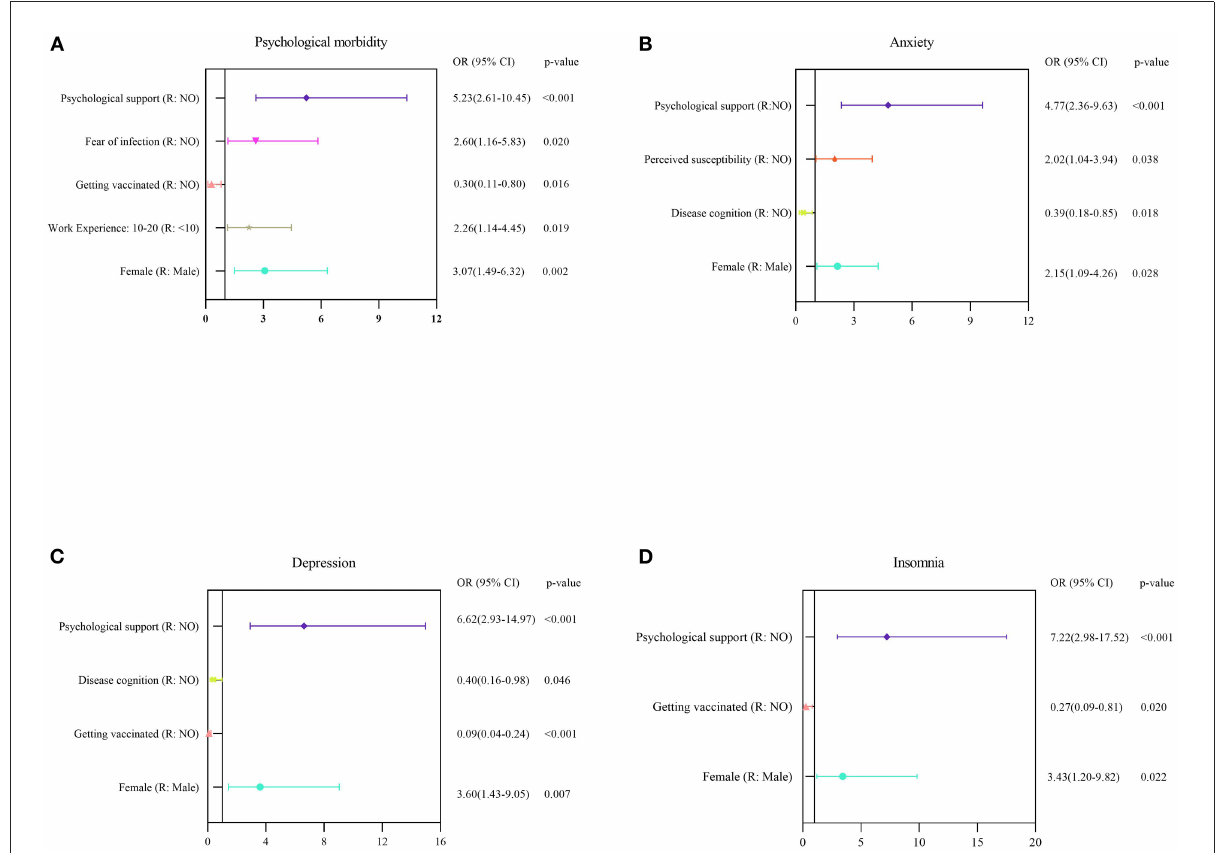
FIGURE3 Multivariate logistic regression analyses for identifying the risk factors linked to mental health outcomes among HCWs. (A–D) Risk factors associated with general psychological morbidity, anxiety, depression, and insomnia, which identified based on the scores of GHQ-12, GAD-7, PHQ-9, and ISI-7,